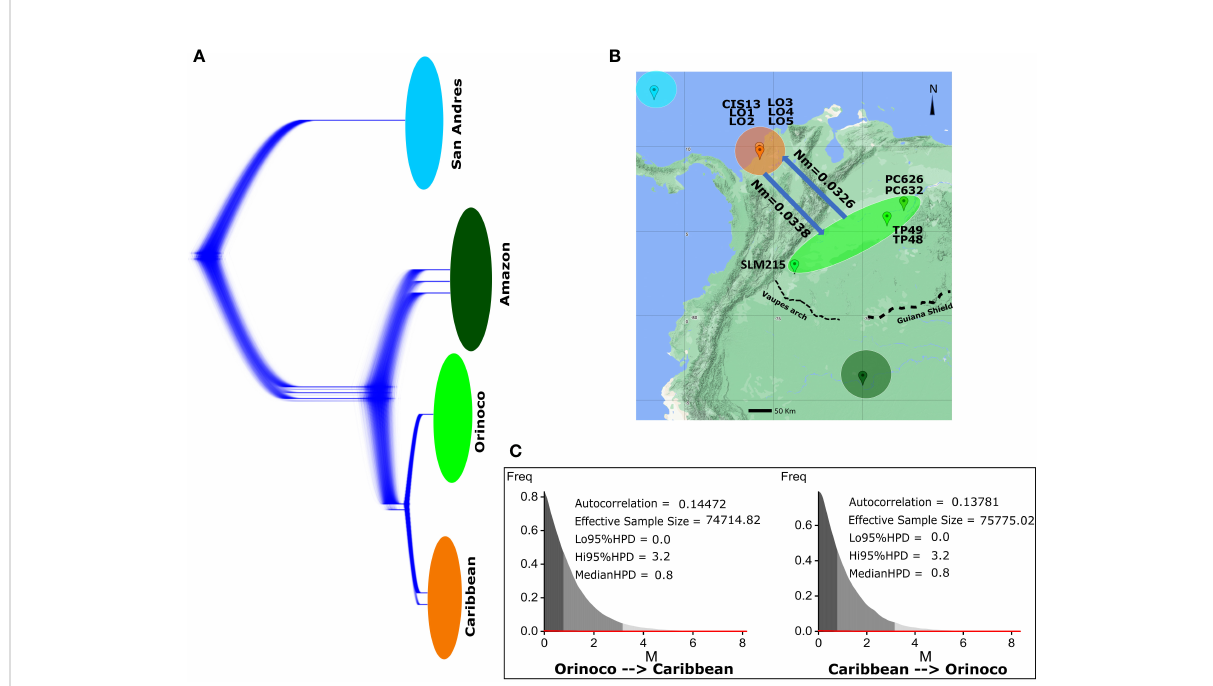
FIGURE 5 Gene fl ow analysis for K scorpioides populations that showed signals of admixture in STRUCTURE (Caribbean/Orinoco), using approaches based on analyses in DensiTree and Migrate. (A) DensiTree analysis of 10,000 genealogies reconstructed in BEAST v1.8.2 (derived from the calibrated phylogenetic tree analysis) showing all variation over the Bayesian probability density of topologies among individuals from all populations, looking for incomplete lineage sorting patterns generated by recent genetic interchange between individuals. (B) Biogeographical representation of the bidirectional gene fl ow in biological scale [number of migrants per generation ( Nm )] between Caribbean and Orinoco populations. (C) Bayesian posterior distribution metrics for the migration “ M ” parameter (mutational scale) between populations, estimated under coalescent methods in the Migrate-n